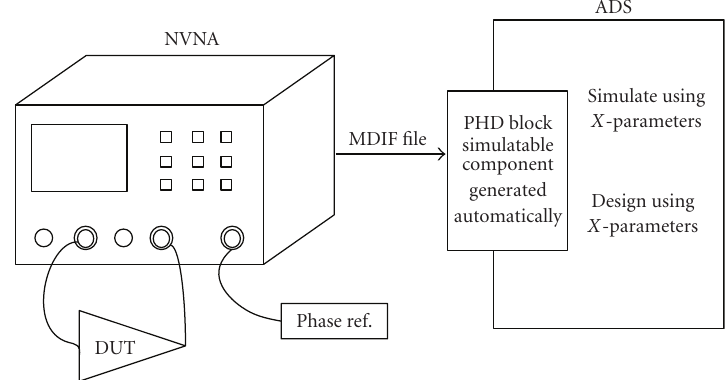
Figure 1: Simplified configuration of an NVNA and ADS workbench for nonlinearity measurements.